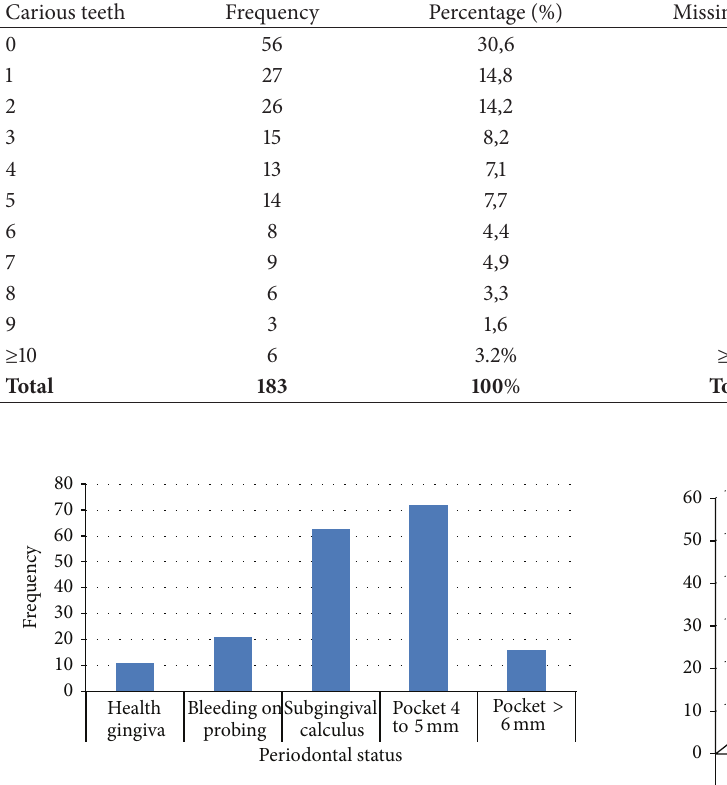
Figure 4: Distribution of the study population according to the periodontal status. Table 5: Carious pathology according to the associated factors.